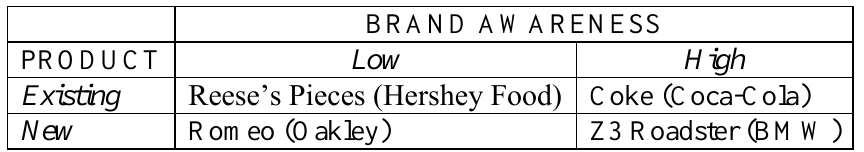
Table 1: Product Placement and Brand